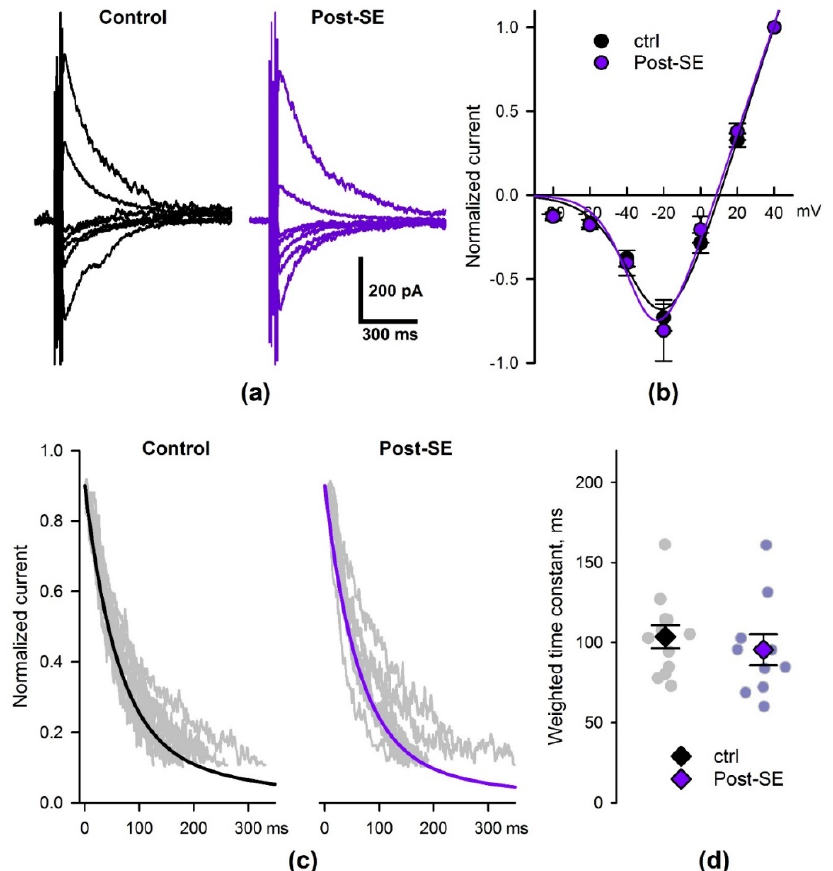
Figure 7. The properties of NMDAR-mediated eEPSC are not altered in 7d post-SE rats. ( a ) A representative set of NMDAR-mediated eEPSCs, recorded at different holding voltages (from +40 to –80 mV, 20 mV increments). ( b ) The average I–V relationships, obtained from the control and 7d post-SE groups and fitted with Equation 1 (see Methods). No differences between control ( n = 12) and post-SE ( n = 10) groups were detected for all parameters ( V 12 : –29 ± 2 vs. –31 ± 3 mV; k : 10.3 ± 0.8 vs. 8.4 ± 1.6; V rev : 9.8 ± 1.4 vs. 7.5 ± 2 mV, respectively; t -test, p > 0.05 for all three comparisons). ( c ) The decays of NMDAR-mediated eEPSCs from the control and post-SE groups. Gray traces represent the superimposed raw experimental recordings. The solid black and purple lines represent the double exponential functions (Equation 2) with the average parameters corresponding to the control and post-SE groups. ( d ) The weighted time constants, obtained for the control and post-SE groups. No significant difference was detected ( t -test, p = 0.5).